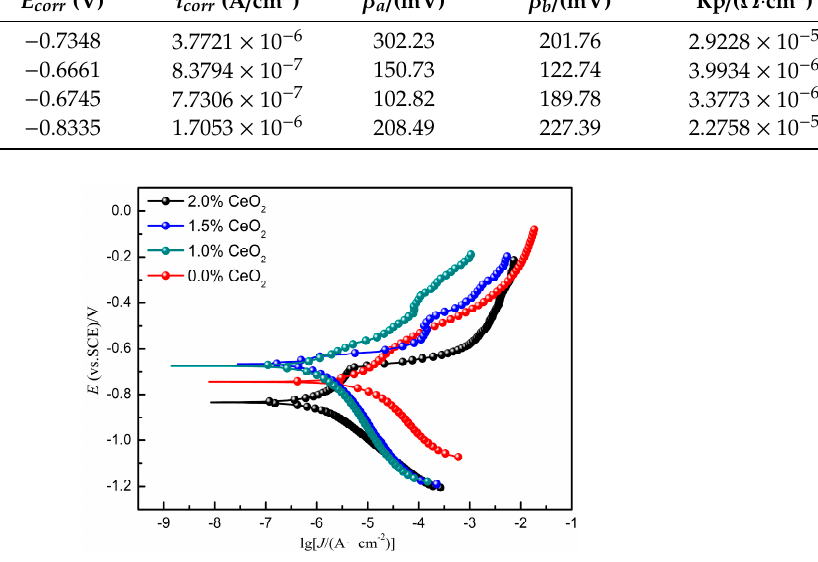
Figure 11. Polarization curves of coatings with different CeO 2 content.